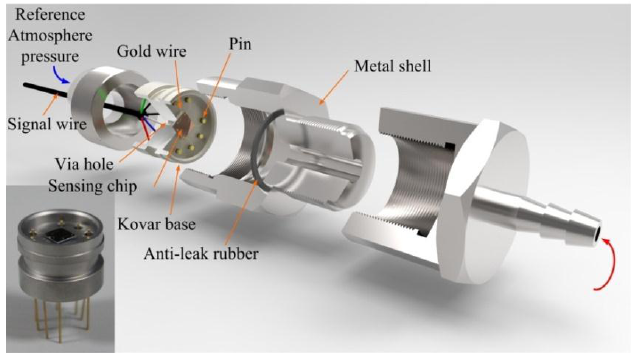
Figure 23. Schematic of the packaged pressure sensor.